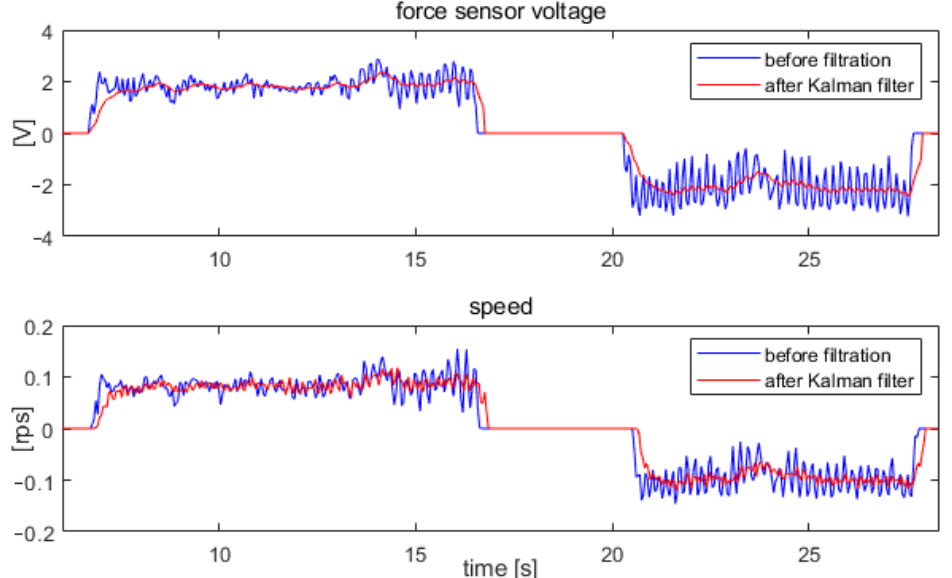
Figure 13. Signal waveforms from the force sensor and after applying the Kalman filter, and the corresponding speed waveforms at the elbow joint.